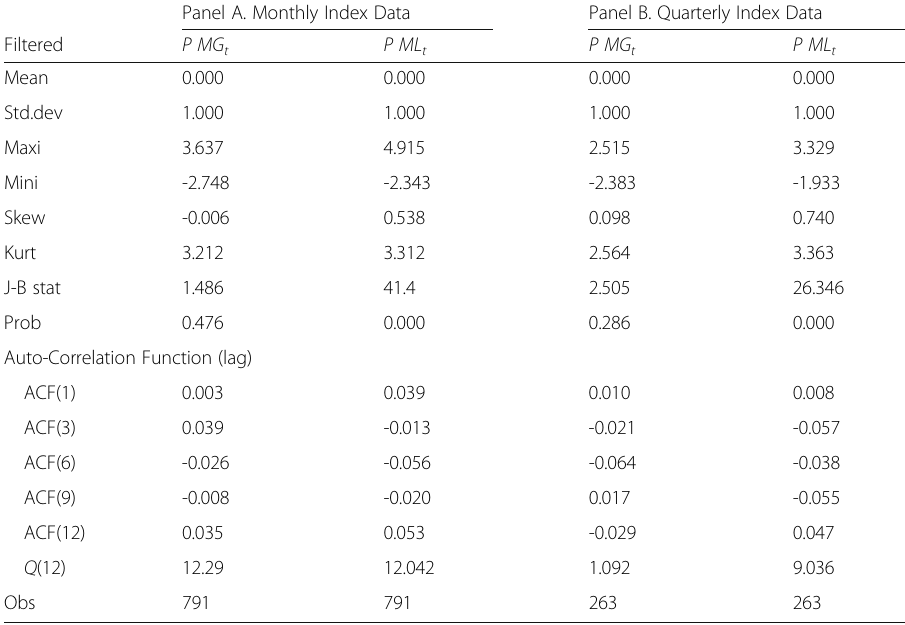
Table 4 Summary Statistics on Filtered PMG and PML Panel A. Monthly Index Data